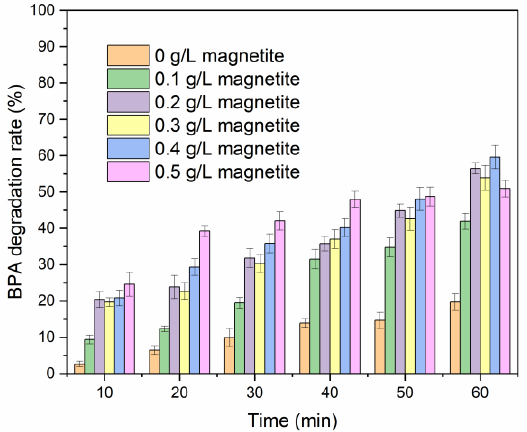
Figure 1. The effect of magnetite dosage on BPA degradation. [BPA] = 5 mg/L, [PS] = 0.2 mM, T = 20 °C, pH = 7.0.